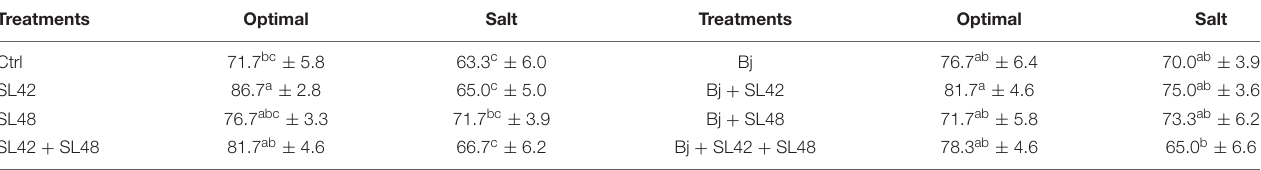
TABLE 1 | Seedling emergence rate (%) of soybean at 7th DAP under optimal and salt stress conditions. Treatments Optimal Salt